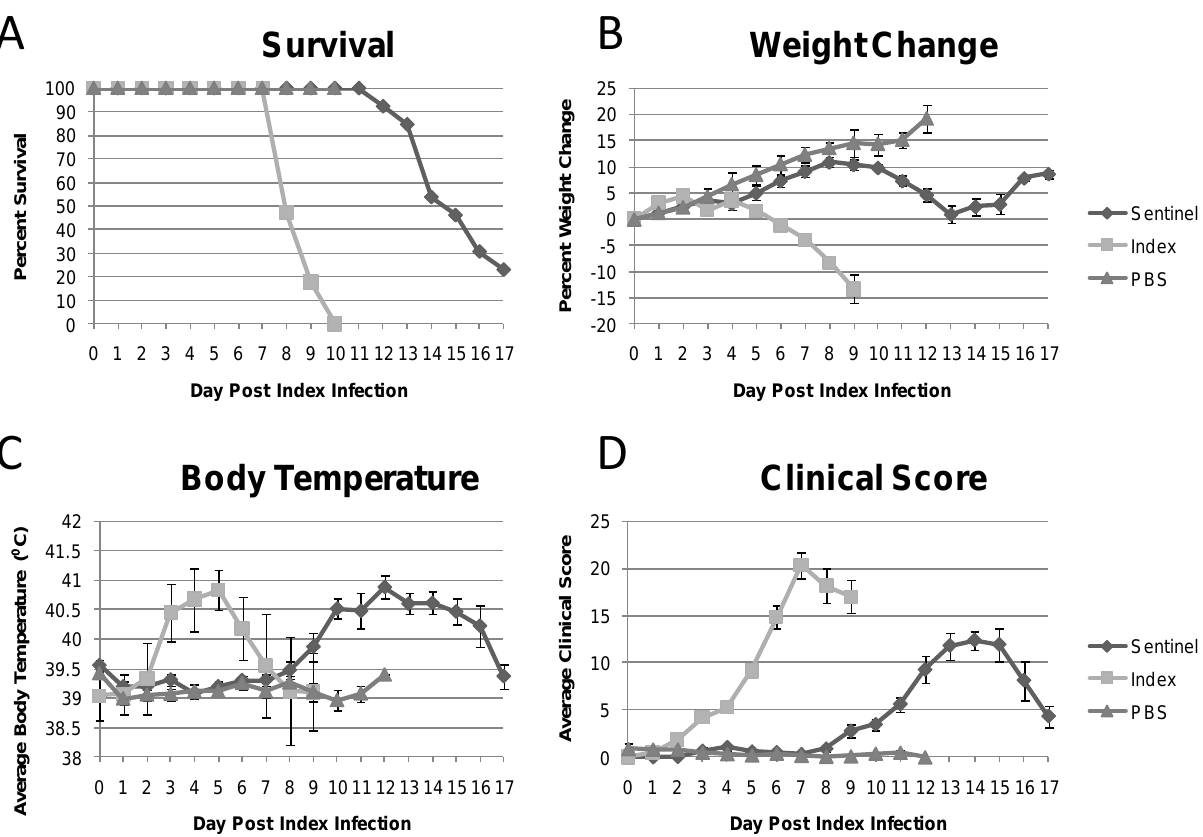
Figure 6. Disease in rabbits lethally infected with RPV via natural aerosol. (A) Survival of naturally infected rabbits (sentinel), infected cage mates providing aerosolized RPV (index) and uninfected control animals (PBS). (B) Average weight change from weight at time of infection for each group. Negative values represent weight loss. (C) Average body temperatures over time. Temperatures over 39.5 °C are considered a fever. (D) Average clinical score over time. Error bars represent SEM. Reproduced with permission from American Society for Microbiology